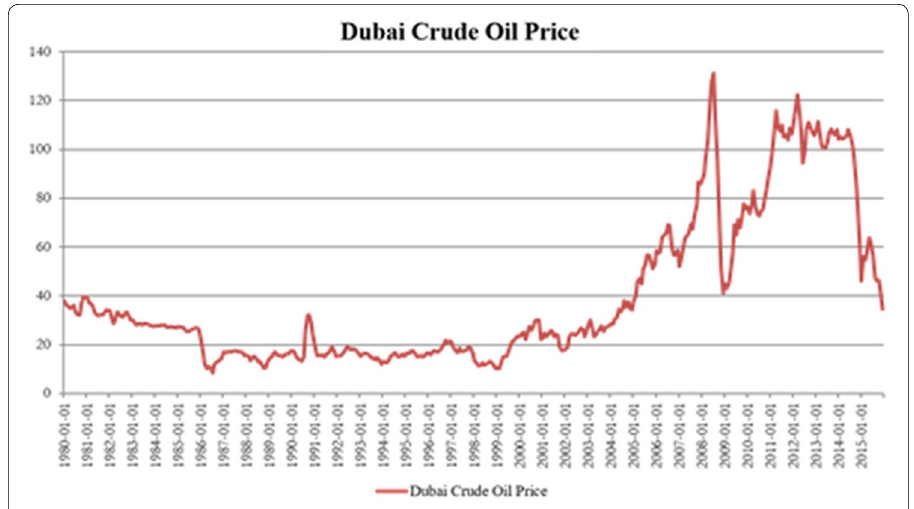
Fig. 1 Historic trend of the Dubai crude oil price